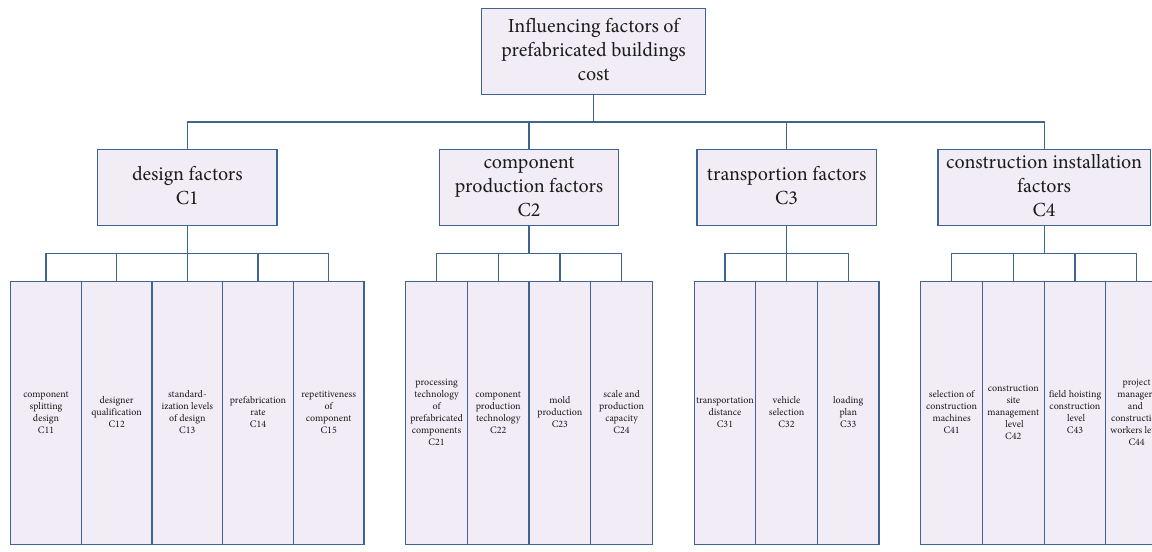
Figure 1: Evaluation index system of influencing factors of prefabricated buildings